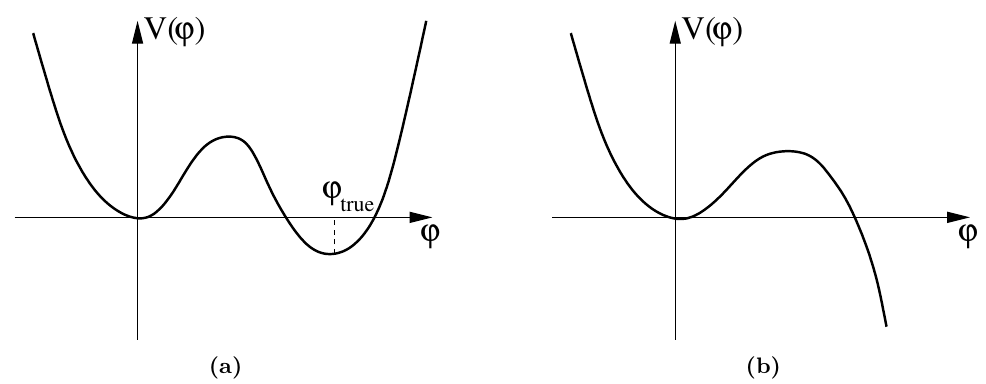
Figure 1. Scalar potential with false vacuum at ϕ = 0 . (a) The true vacuum exists at a finite value of the field. (b) The potential is unbounded from below and the false vacuum decay leads to the run-away ϕ → + ∞